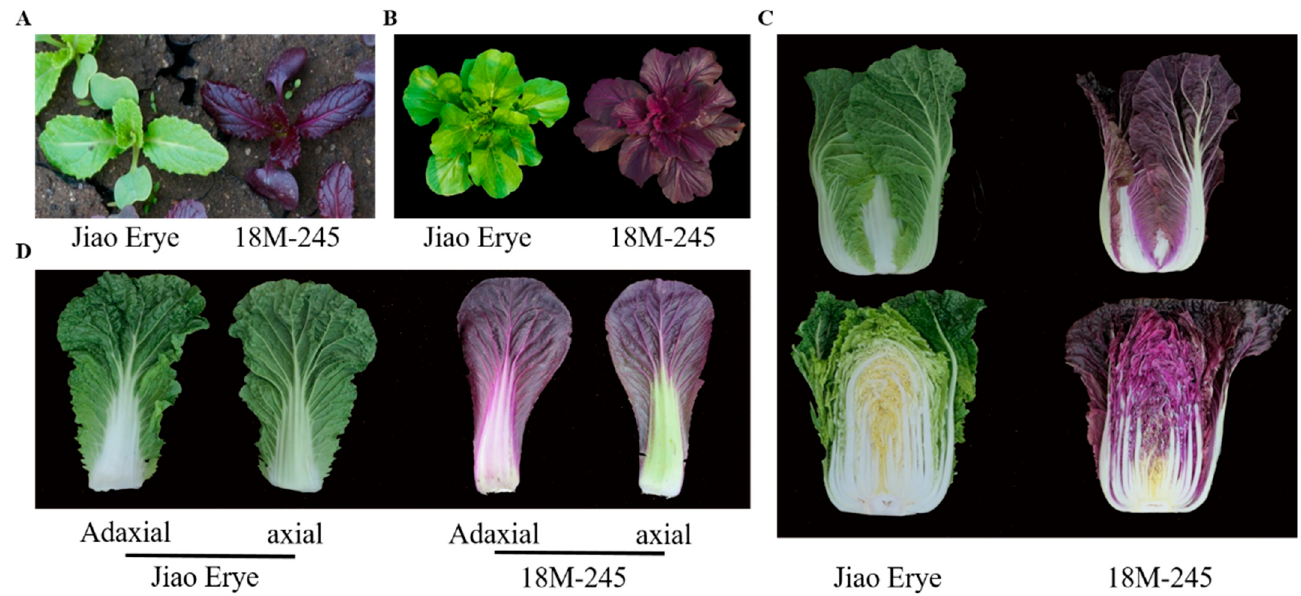
Figure 1. The purple color trait of 18M-245. Compared with the green Chinese cabbage parent, 18M-245 displayed deep purple leaves at both the seedling ( A ) and adult stages ( B , C ). A deep purple color was also displayed in both the outer and inner leaves of the leaf head ( C ), and on adaxial and abaxial surfaces of the leaves, veins and adaxial petioles ( D ).